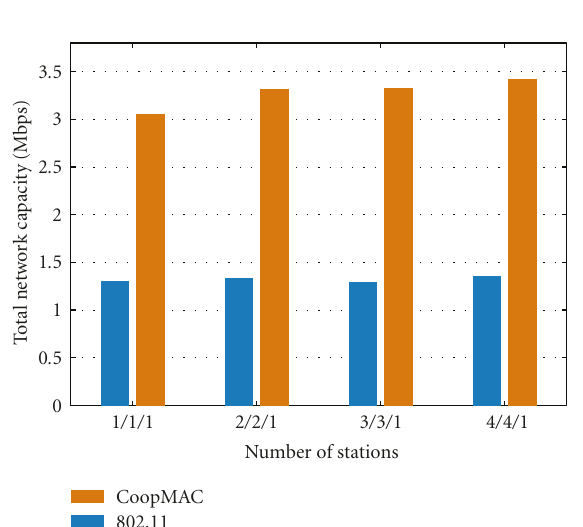
Figure 11: Throughput comparison.